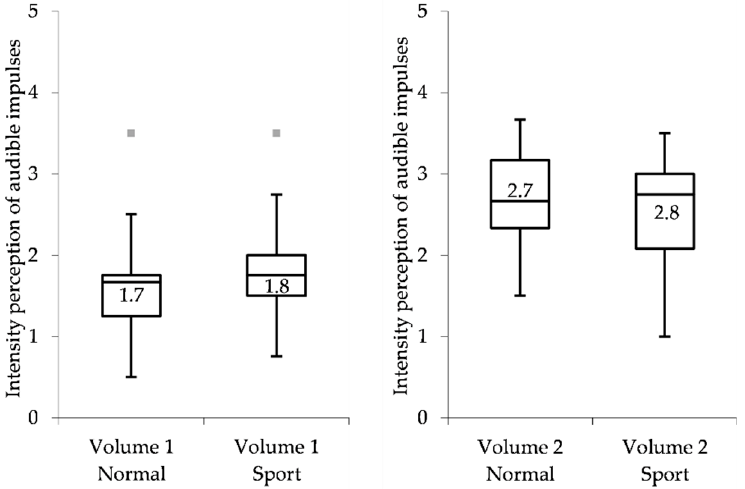
Figure 5. Intensity perception of audible impulses for volume 1 ( Left ) and for volume 2 ( Right ) in the two suspension modes normal and sport, rating scale ranging from 0 “not perceptible” to 5 “very strongly perceptible”. Table 4. Statistical evaluation: influence of tactile impulses on the perception of audible impulses (N: Normal, S: Sport). No.